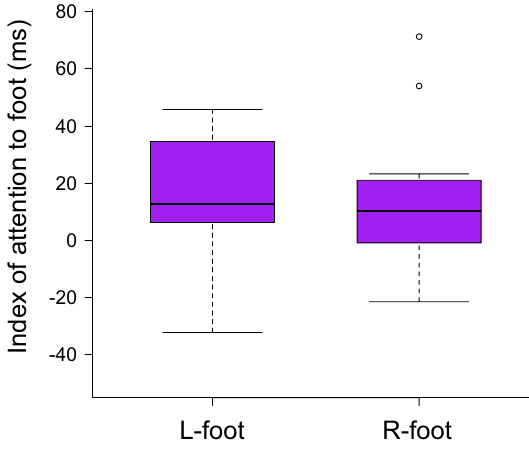
Figure 4. Box plots showing index of attention to the left and right foot in healthy adults. There was no significant difference between the index of attention to the left foot (L-foot) and right foot (R-foot). Circles represent outliers.